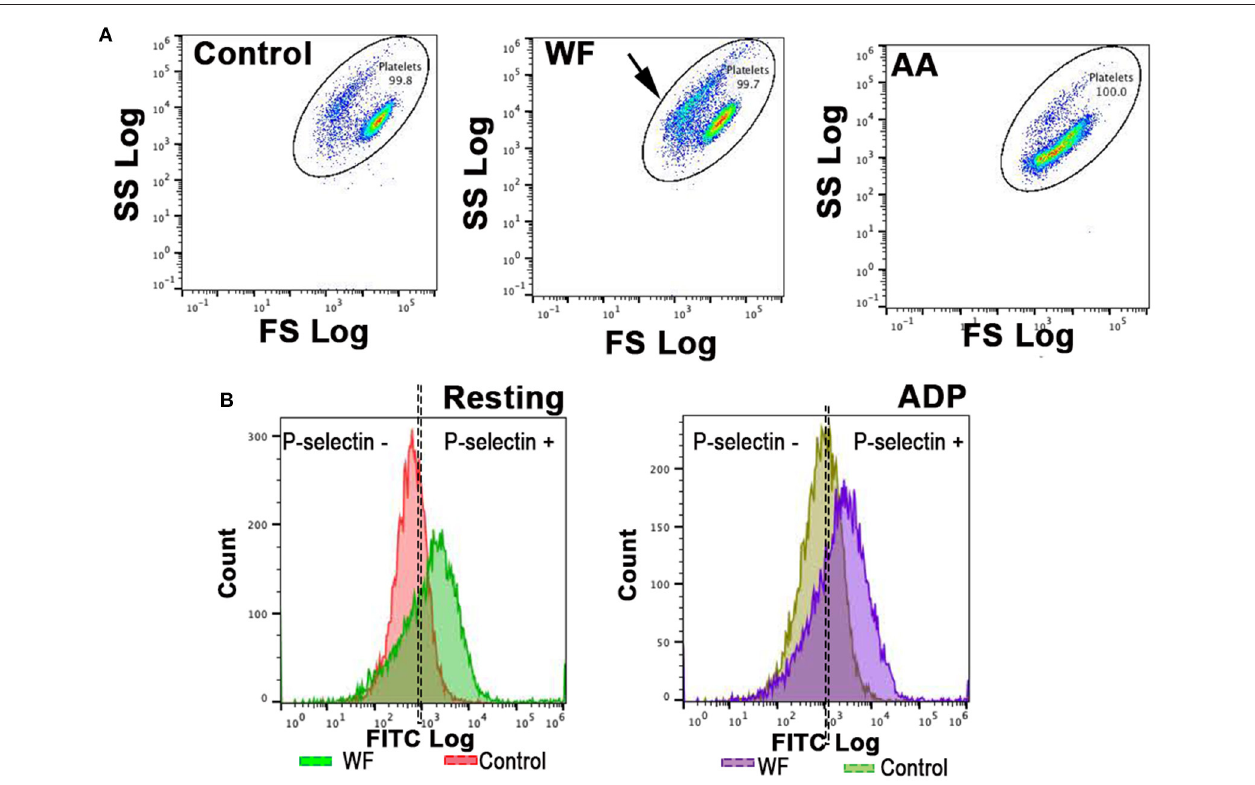
FIGURE 1 | Representative scatter plot diagrams and histograms of flow cytometric analysis of platelets in a cat with wildfire (WF) related injuries and 1 healthy control cat. (A,B) Platelets were identified by forward (FS) and side scatter (SS) properties. Note the shift in scatter properties (arrows) in platelets from a cat in WF group compared to those in the healthy control indicating shape change and degranulation. Arachidonic acid (AA)-treated (1 µ M) platelets in a WF group cat resulted in a shift in scatter properties indicative of intact granules and size. (B) Representative histograms illustrating the number of platelets expressing P-selectin in the absence (resting) or presence of 20 µ M ADP in a WF cat and healthy control. Note the upregulation in P-selectin in either resting or ADP-activated platelets in the WF cat compared to healthy